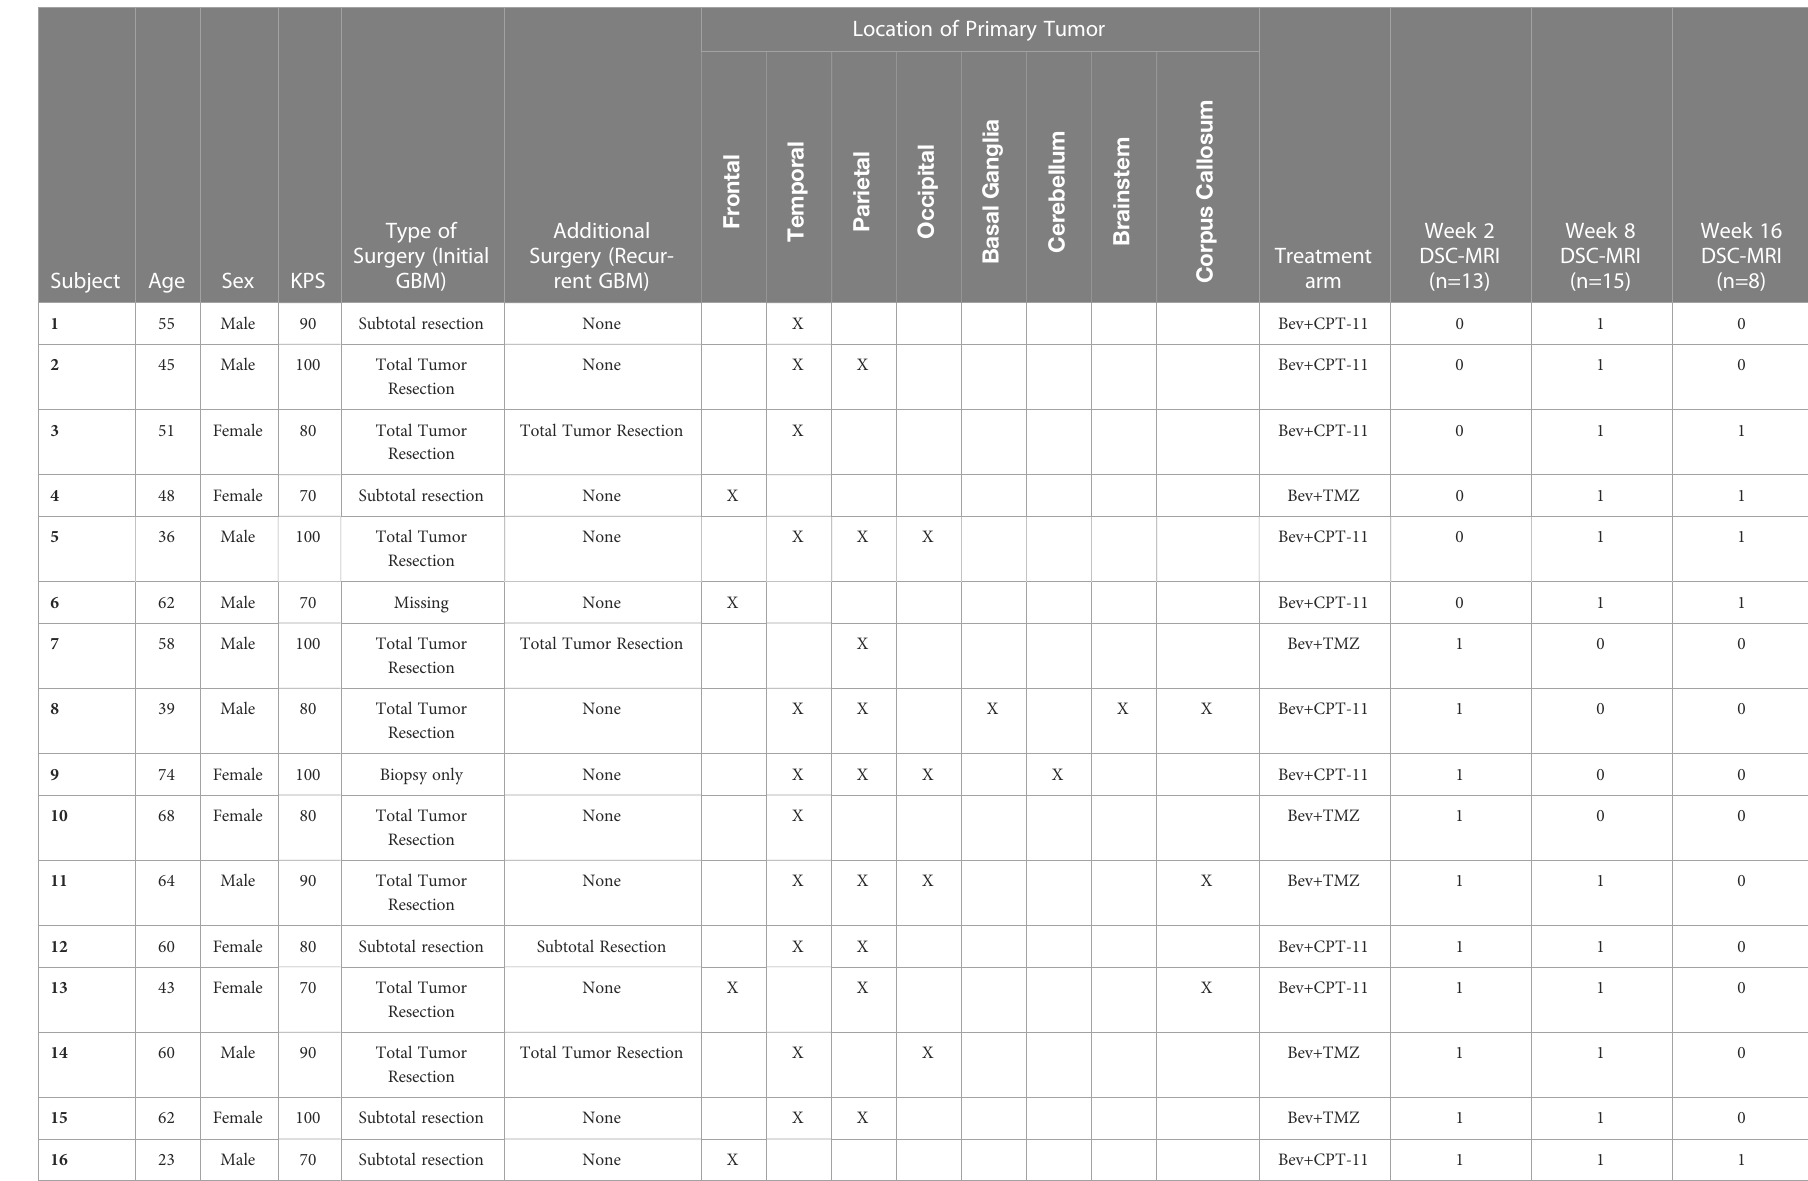
TABLE 1 Demographic and clinical data for the cohort of 2D-T1 non-progressors with available week 2, week 8 or week 16 DSC-MRI